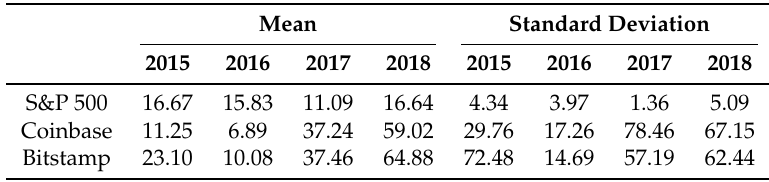
Table 3. Comparison over the period 2015–2018 between daily average realized variance of Bitcoin, measured using Coinbase and Bitstamp 5-min returns and S&P 500 measured using the volatility index VIX. The first four columns report the sample while the last four columns the standard deviation (i.e., the volatility of volatility).